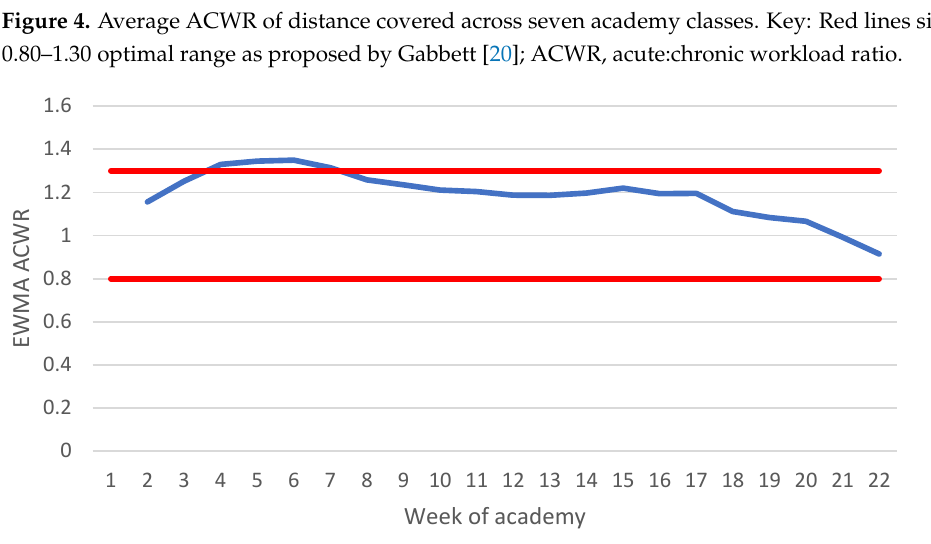
Figure 5. Average EWMA ACWR of distance covered across seven academy classes. Key: Red lines signify 0.80 – 1.30 optimal range as proposed by Gabbett [20]; EWMA ACWR, exponentially weighted moving average acute:chronic workload ratio.